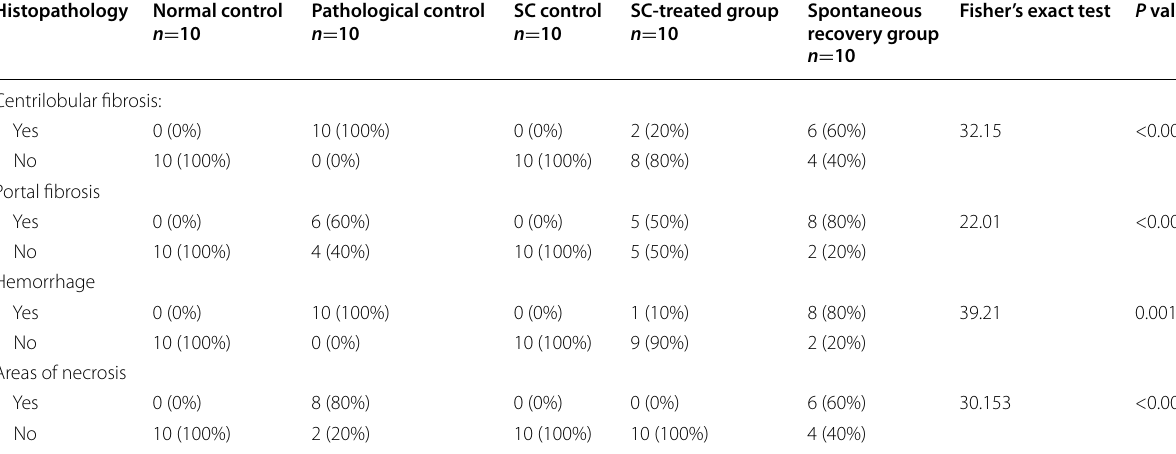
Table 2 Comparison between the studied groups regarding their histopathology Histopathology Normal control